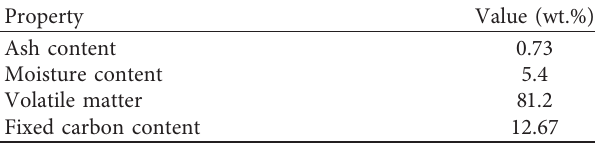
Table 3: Proximate analysis of raw bamboo wood powder. Table 1: Proximate composition of raw corncob.